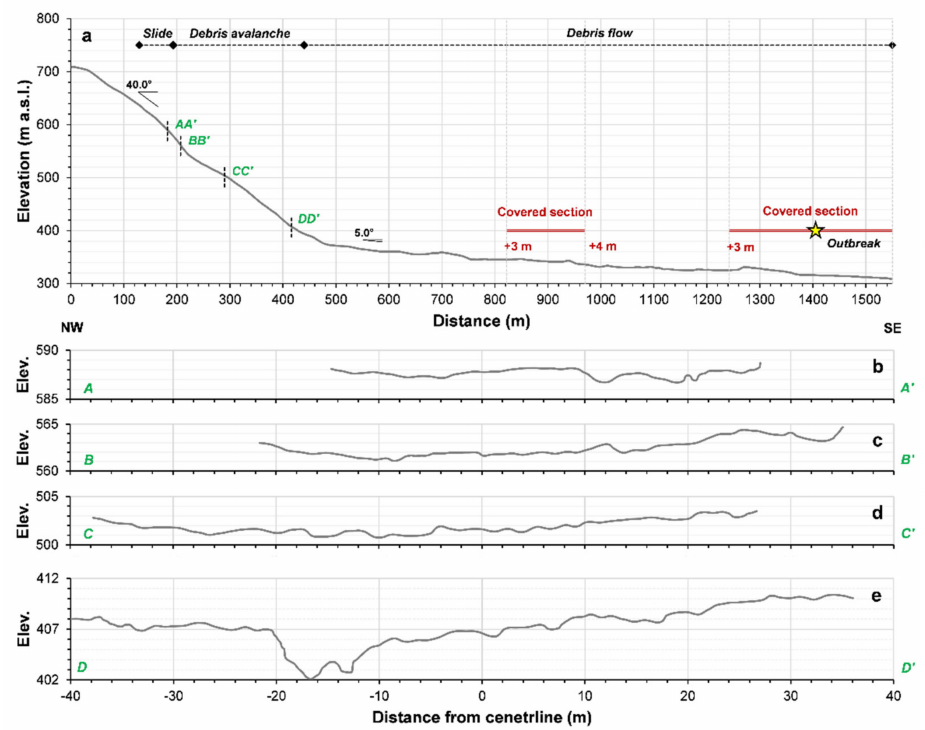
Figure 11. ( a ) Longitudinal topographic profile along the landslide area, showing the types of movement and slope. Covered sections of the Caudino Torrent and flow thickness (red numbers) are also shown. ( b – e ) Topographic profiles from the UAV survey (the location of the traces AA’, BB’, CC’ and DD’ is shown in Figure